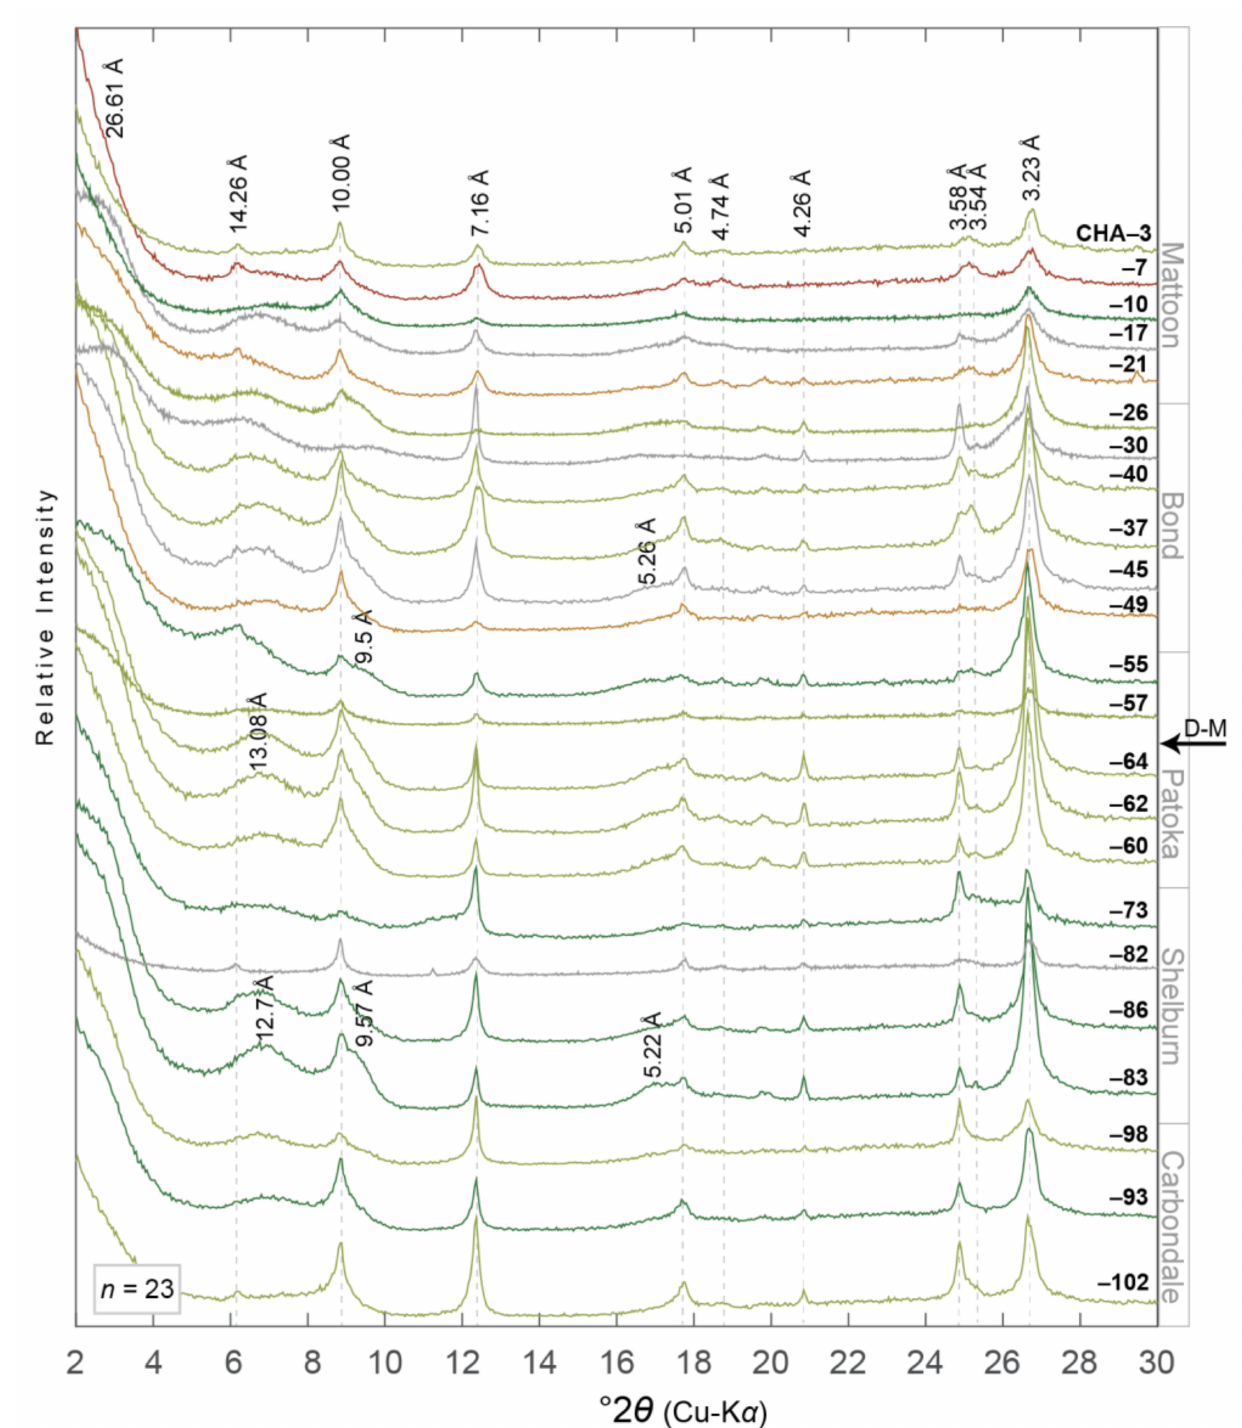
Figure 5. XRD patterns of ethylene glycol saturated oriented aggregates of the <2.0 µ m equivalent spherical diameter clay- sized fraction from paleosols in the Illinois State Geological Survey (ISGS) #1 City of Charleston (CHA) core ( n = 23). Diffraction patterns are organized with respect to their relative stratigraphic position, i.e., CHA-102 and CHA-3 are stratigraphically the lowest and highest samples, respectively. D-spacing information for minerals discussed herein are noted vertically and in angstroms (Å). Diffraction patterns are colored to correspond with paleosol type, i.e., grey = gleyed Protosol (Pe-dotype B [43,44]), dark green = gleyed Vertisol (Pedotype C), light green = gleyed calcic Vertisol (Pedotype D), ochre = gleyed vertic Calcisol (Pedotype E), and red = calcic Vertisol (Pedotype G). D-M = Desmoinesian–Missourian boundary. Core location noted in Figure 2. See Tables 1 and 2 for more